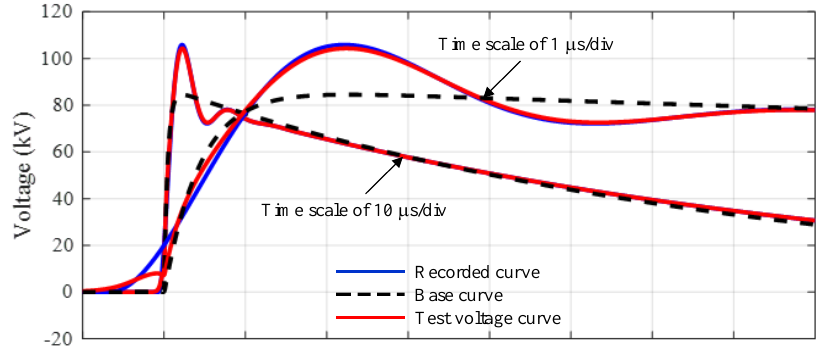
Figure 9. The assessed full lightning impulse waveforms in the LI-A1 case (waveform data provided by [13]).